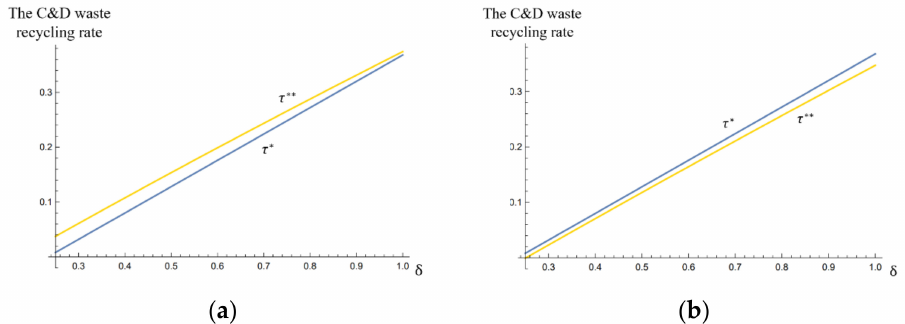
Figure 5. The e ff ects of the unit subsidy δ on the recycling rates τ ∗ and τ ∗∗ ( a ) with the highest fixed payment α = 4, and ( b ) with the highest fixed payment α =